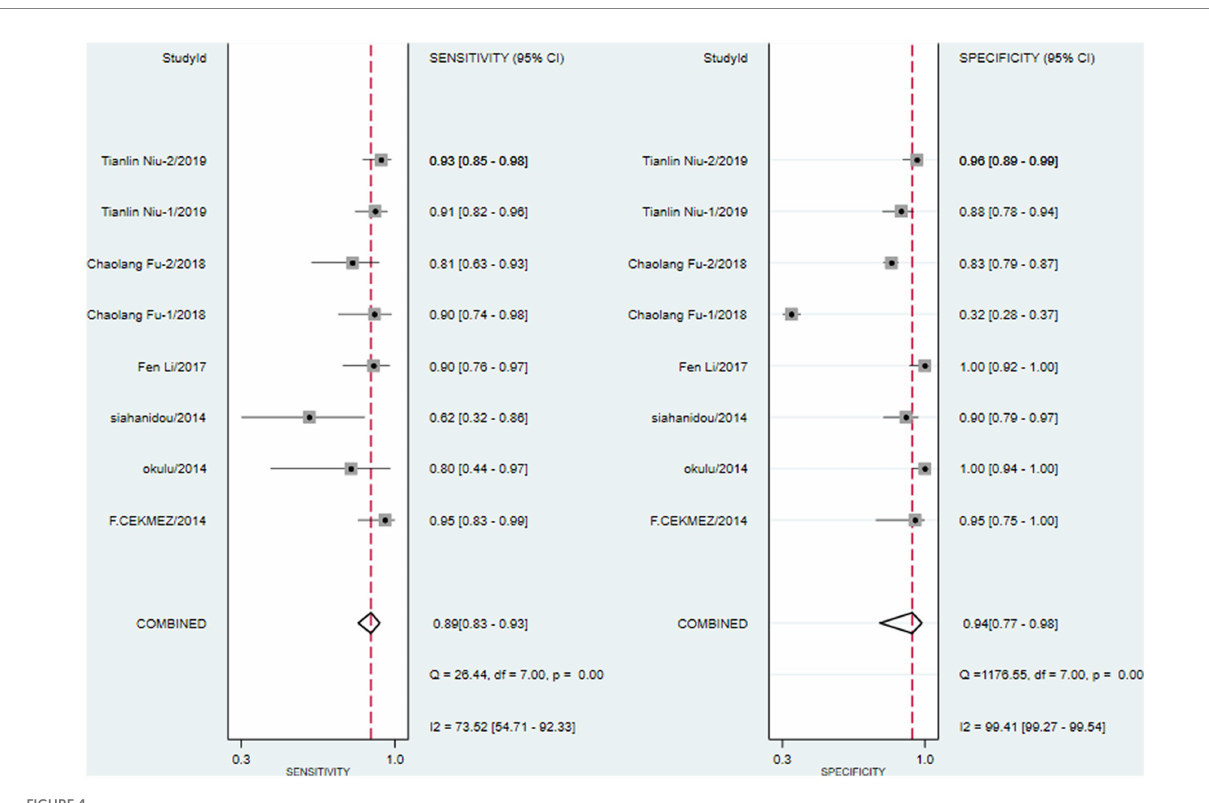
FIGURE 4 Forest plots for pooled sensitivity and specificity of neonatal sepsis diagnosis by soluble Urokinase-type plasminogen activator receptor (suPAR).